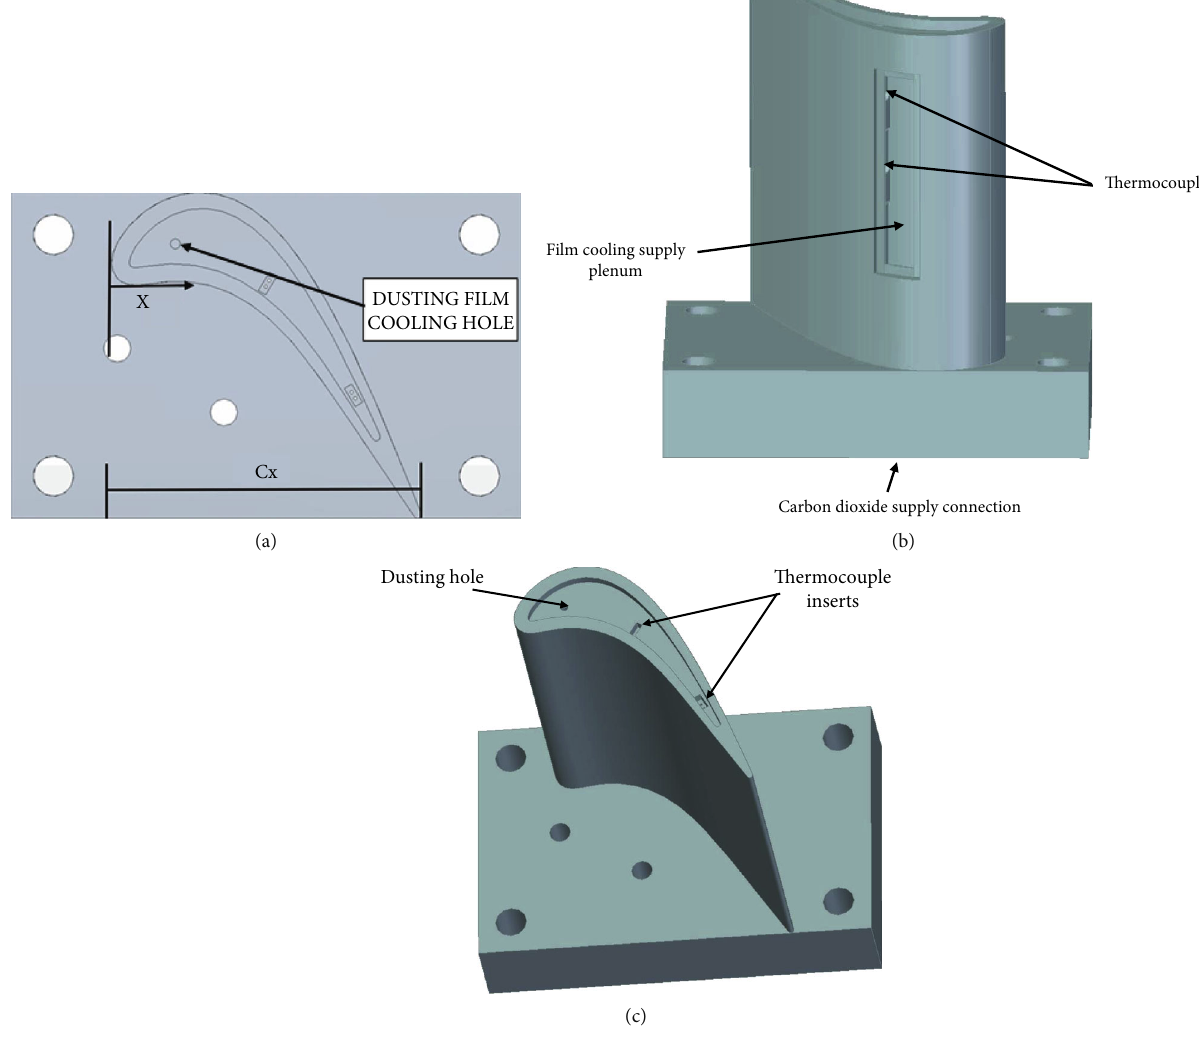
Figure 2: (a) Details of A1 fi lm cooling con fi guration of the fi lm-cooled blade. (b) Cut away view of the A1 instrumented blade. (c) Three dimensional view of the A1 fi lm-cooled